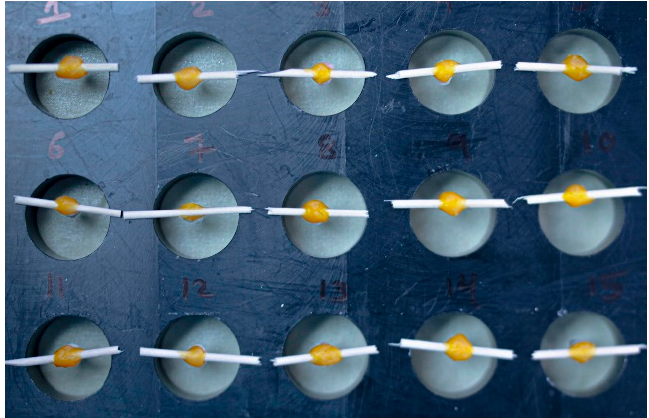
Figure 1. Teeth were mounted in acrylic-resin blocks using a test mount former.